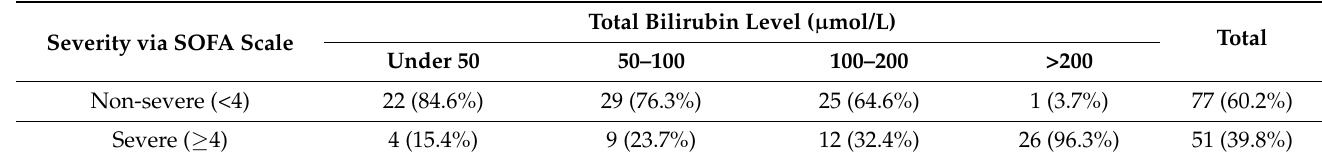
Table 4. Distribution of patients by severity of disease and level of hyperbilirubinemia ( p < 0.001).